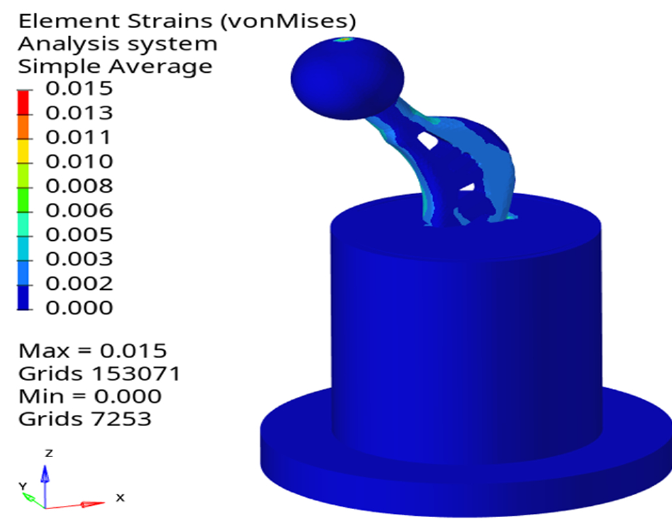
Figure 12. Overall stain nephogram of the proposed femoral